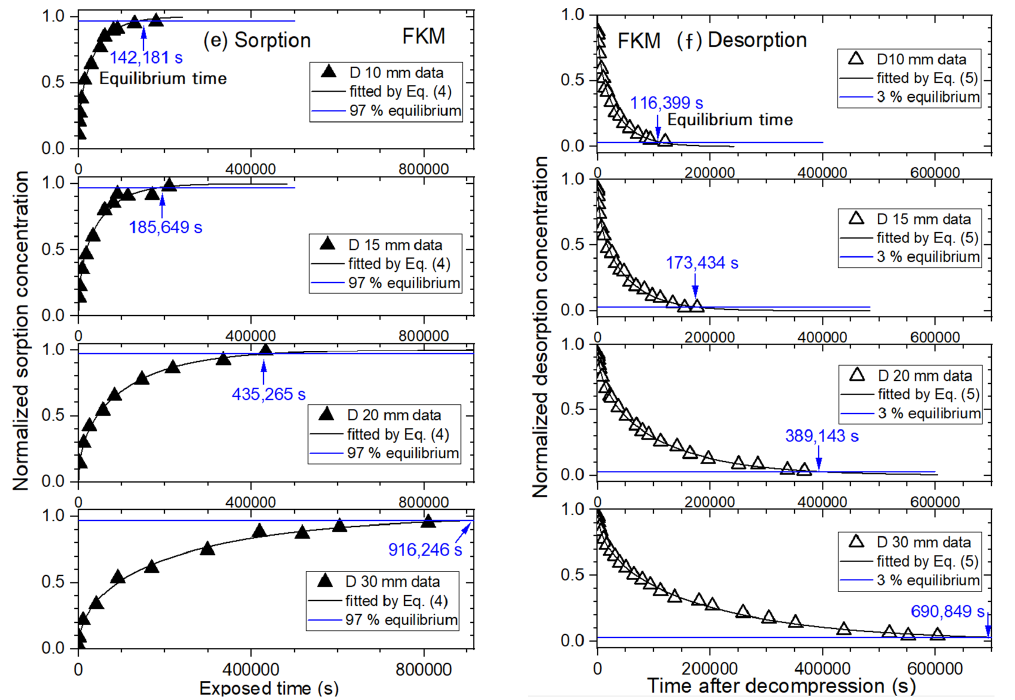
Figure 6. ( a ) Normalized sorption and ( b ) desorption contents versus time for spherically-shaped NBR with diameters of 10 mm, 15 mm, 20 mm, and 30 mm. ( c ) Normalized sorption and ( d ) desorption contents versus time for spherically-shaped EPDM with diameters of 10 mm, 15 mm, 20 mm, and 30 mm. ( e ) Normalized sorption and ( f ) desorption contents versus time for spherically-shaped FKM with diameters of 10 mm, 15 mm, 20 mm, and 30 mm. The arrow indicates the equilibrium time of sorption and desorption. Similar to NBR, Figure 6c,d shows normalized sorption and desorption curves, re- spectively, for EPDM. The corresponding sorption equilibrium times (blue arrow) ob- tained for EPDM were 39,847 s for 10 mm, 64,944 s for 15 mm, 116,499 s for 20 mm, and 182,827 s for 30 mm diameters. The desorption equilibrium times (blue arrow) obtained for EPDM were 27,901 s for 10 mm, 52,132 s for 15 mm, 67,095 s for 20 mm, and 132,639 s for 30 mm diameters.